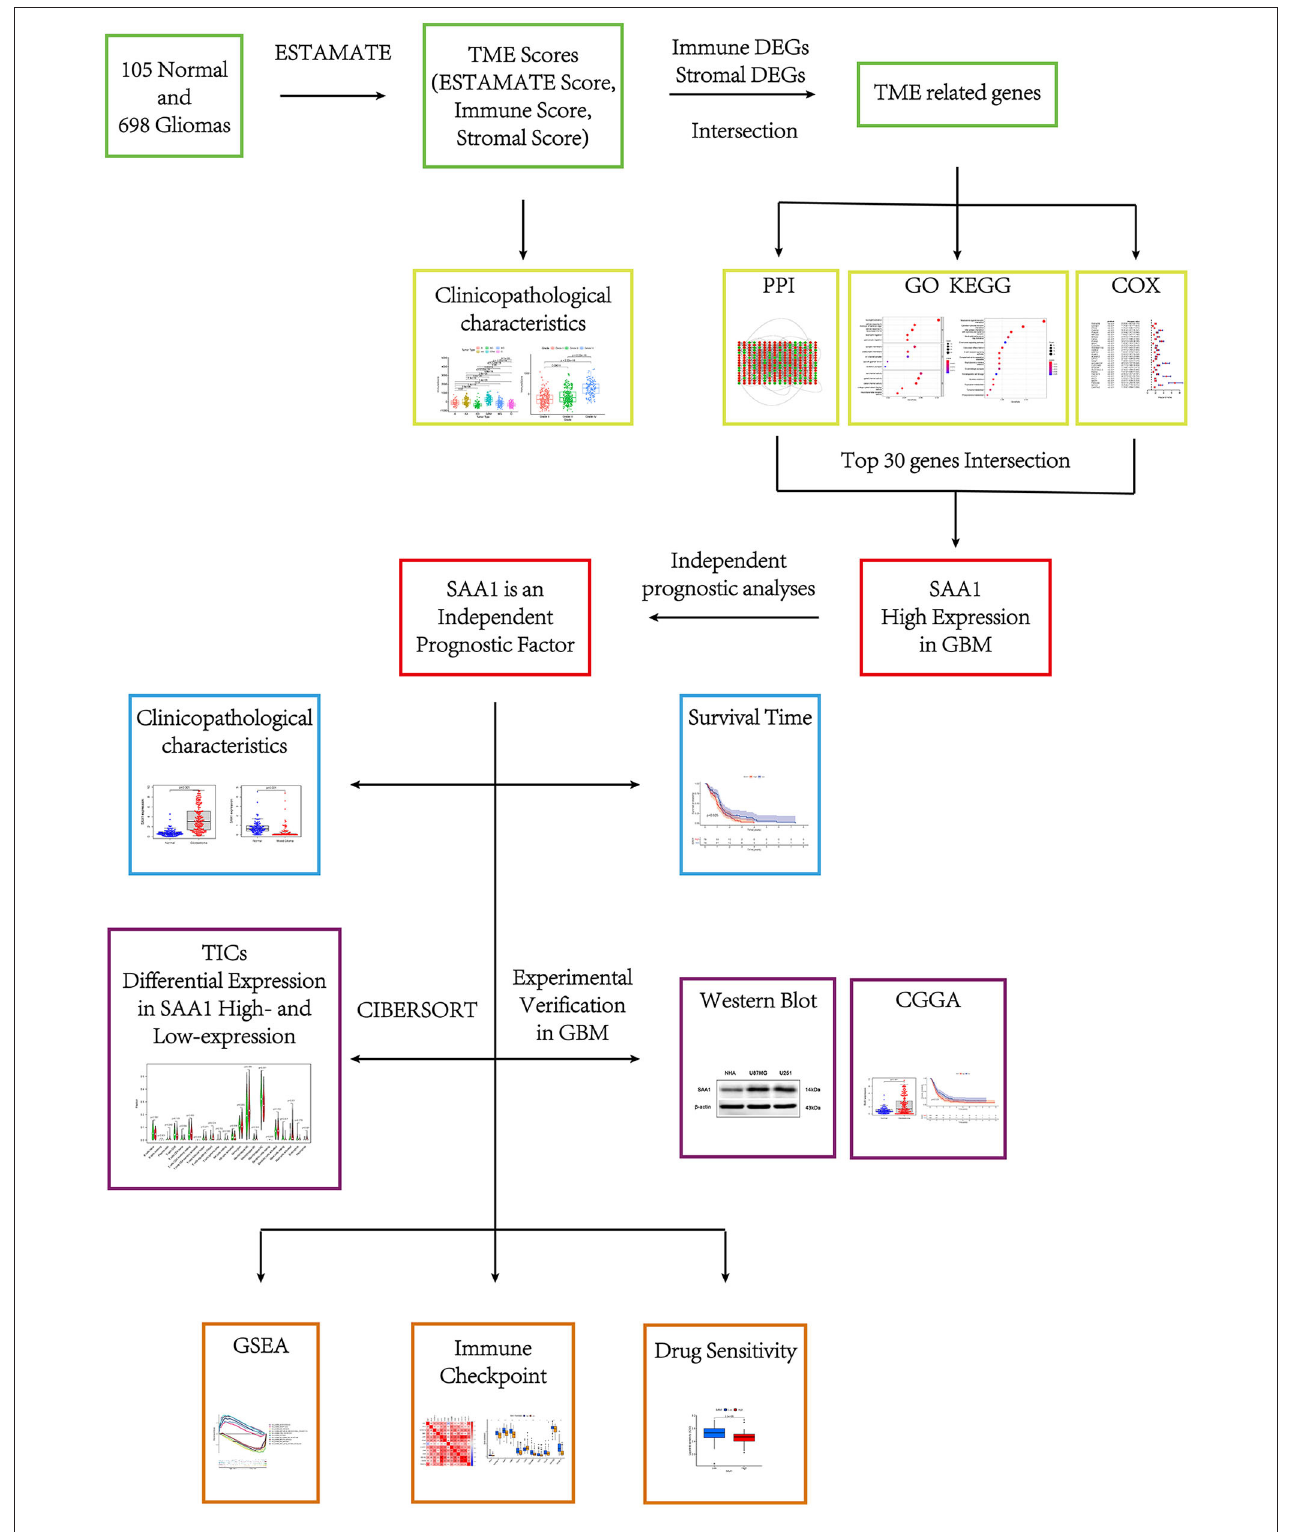
FIGURE 1 | Research process of this